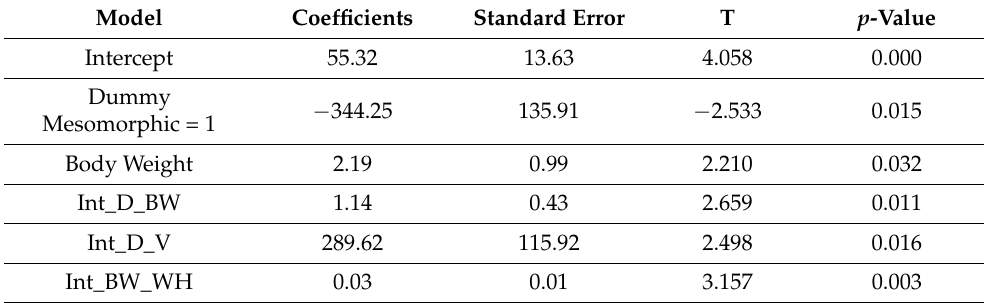
Table 5. Coefficients of stepwise backward regression for the dependent variable Thoracic